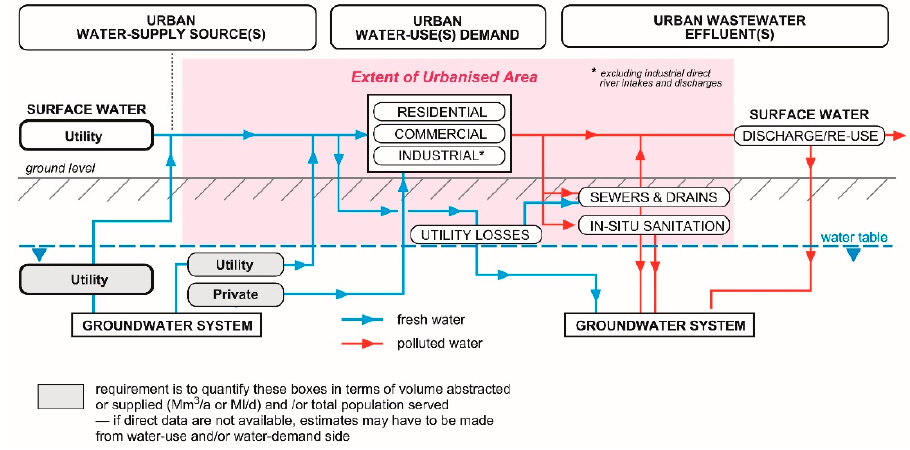
Figure 2. Groundwater relations within the urban water-cycle.